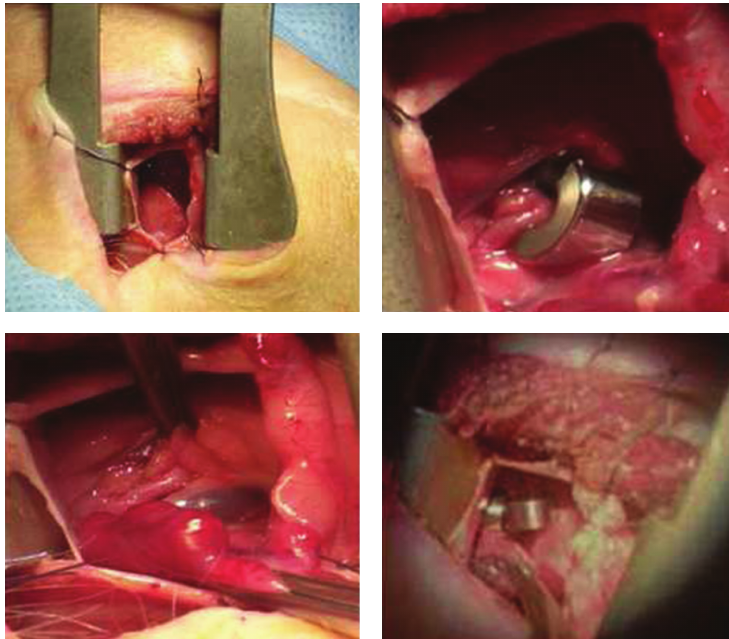
Figure 2: After incision in the thorax in the 4-5th intercostal space, the pericardium is opened. The left atrium is reclined, the atrioventricular groove dissected, and the circumflex branch of left coronary artery is exposed. The constrictor is placed around it. A second constrictor is then placed around the left anterior descending artery.